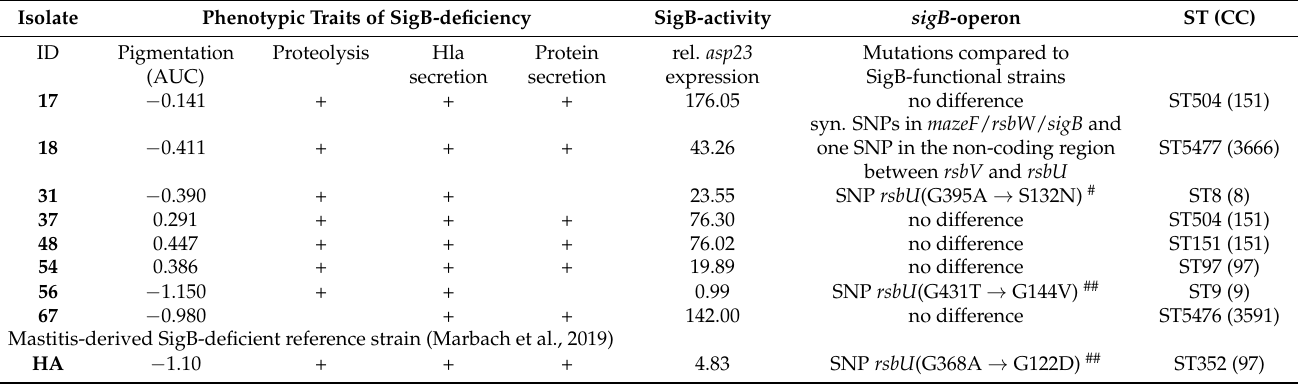
Table 1. Characteristics of isolates presenting the SigB-deficient phenotype.